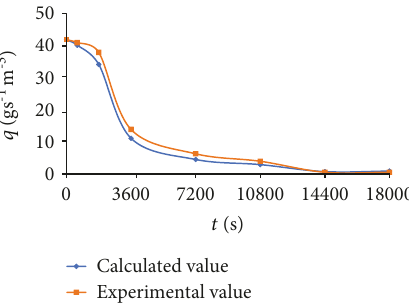
Figure 10: Comparison of the experimental and calculated values from the time-varying curves of mass-loss